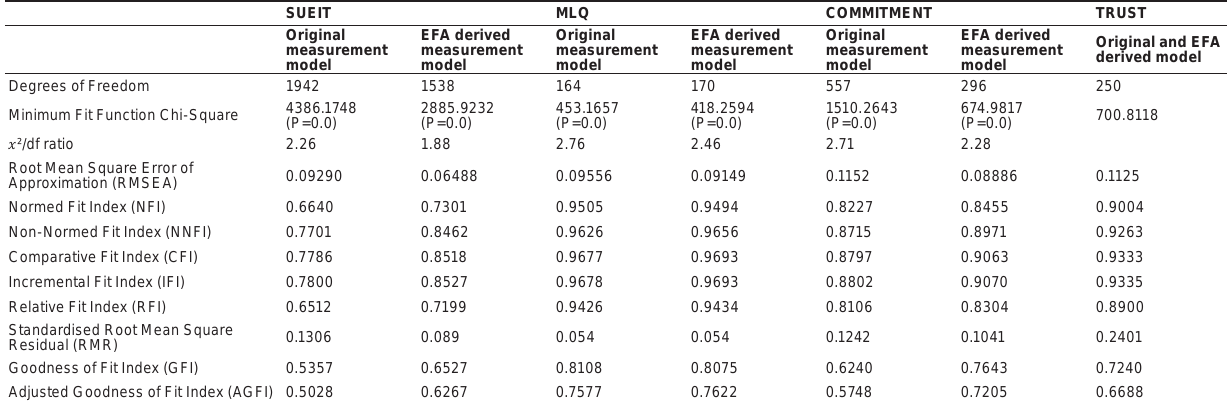
taBle 2 Goodness of fit statistics for the various measurement